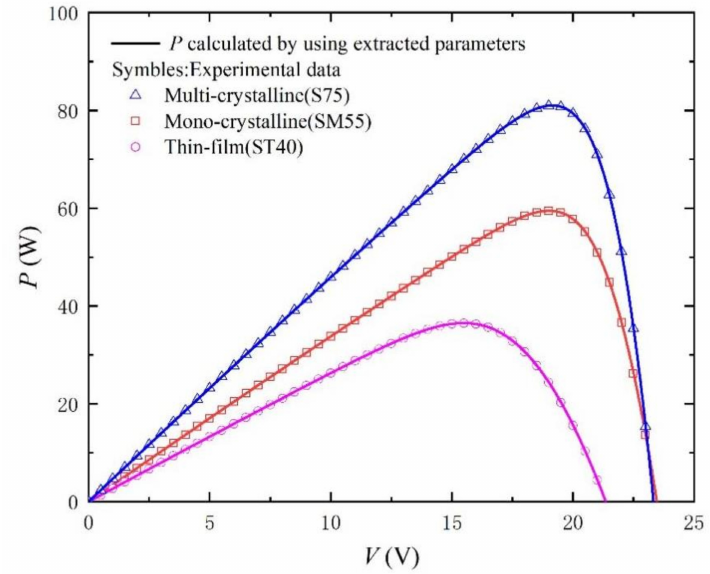
Figure 7. P-V curves measured from experimental data [33] for different PV modules and calculated by using the extracted parameters listed in Table